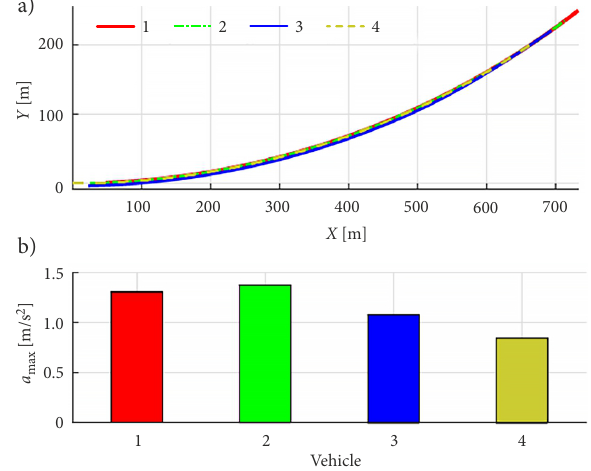
Figure 10. Planned paths and maximum resultant accelerations